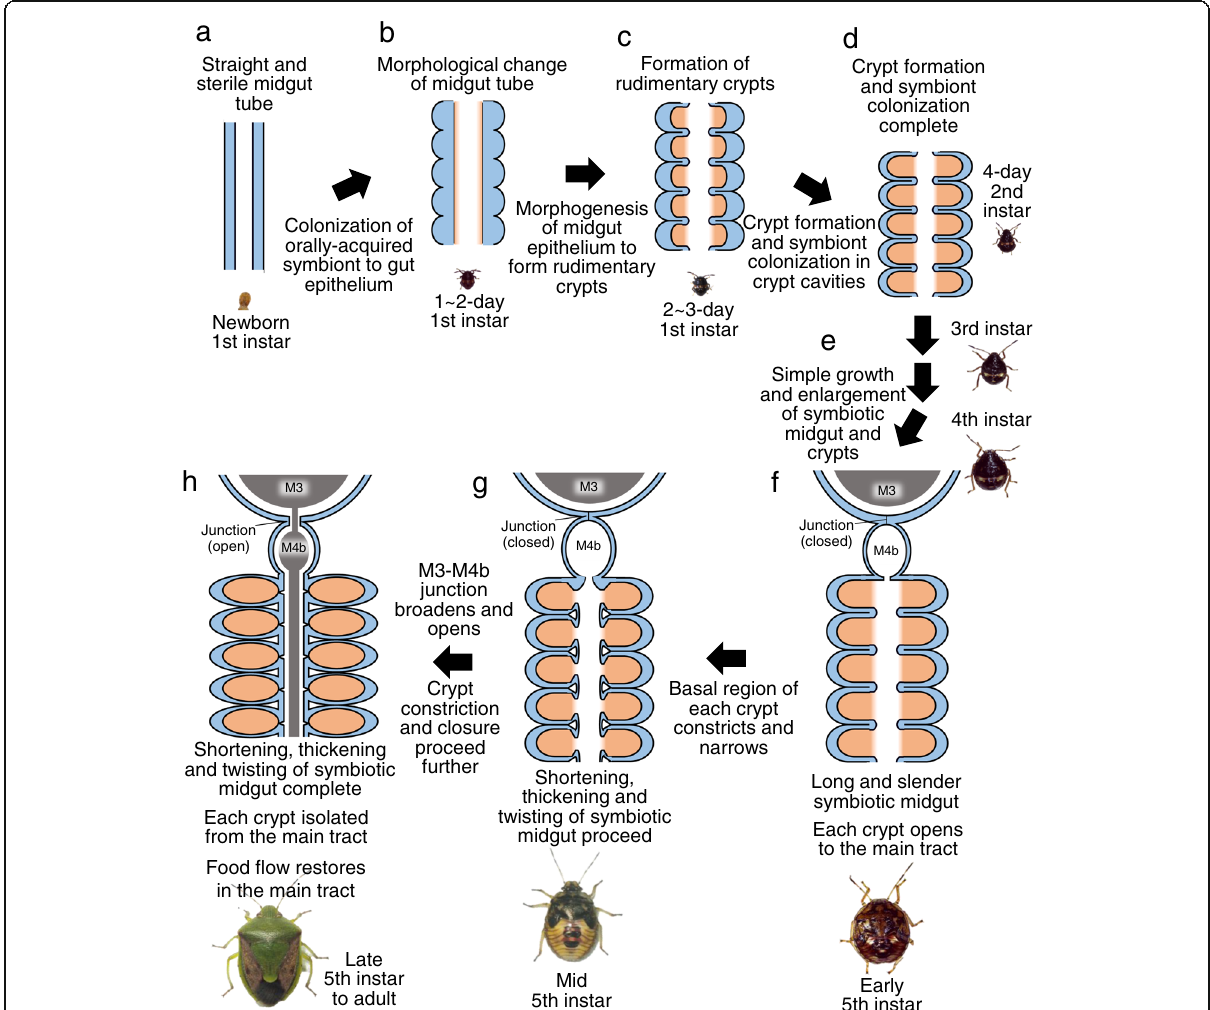
Fig. 8 Schematic diagram of the morphogenetic events observed in the midgut symbiotic organ during the development of P. stali . Blue, orange, and gray show host ’ s intestinal epithelia, symbiotic bacteria, and food flow, respectively. a Newborn first instar nymph. b First instar nymph 1 – 2days after hatching. c First instar nymph 2 – 3days after hatching. d Second instar nymph on the day of molting. e Second, third and fourth instar nymphs. f Early fifth instar nymph. g Mid fifth instar nymph. h Late fifth instar nymph to adult. For detail, see the main